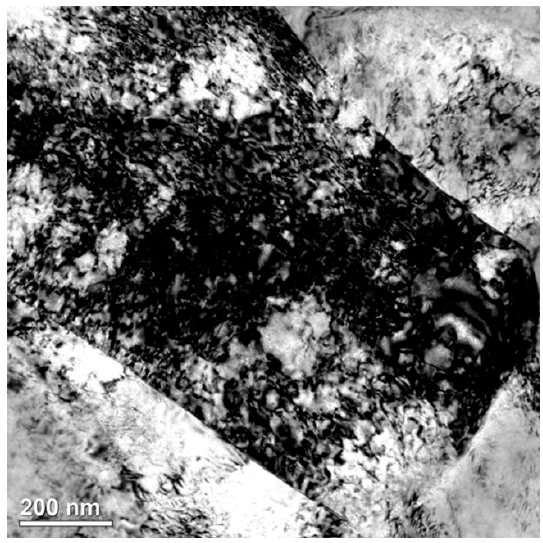
Figure 15. TEM bright field image showing tangle dislocations in an austenite grain after tested to fracture at 350 °C.